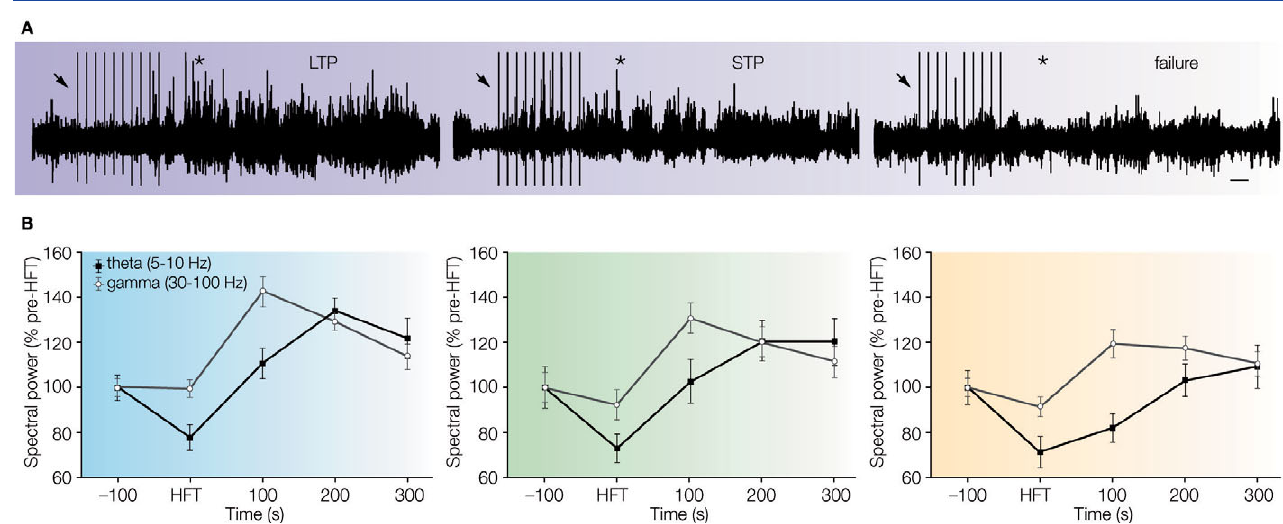
Figure 1 | Transient enhancement of theta and gamma power in the post-tetanisation period correlates with potentiation of synaptic transmission in the dentate gyrus of freely moving rats. (A) Examples of EEG epochs, which comprise 100 s long periods of tetanisation (200 Hz, 10 trains: fi rst train is marked by arrow) and following 300 s, recorded in rats that showed either LTP (left panel), STP (middle panel) or failure of potentiation (right panel), respectively. Asterisk denotes the period immediately after HFT, when the amplitude of network oscillations is higher in LTP and STP cases, in comparison with failed potentiation. Scale bar: 20 s. (B) Successful potentiation (LTP and STP) of synaptic transmission is associated with a prominent increase of the relative theta and gamma power par- ticularly in the period encompassing 100 s after tetanisation. The results were pooled for LTP, STP and failure groups and presented as Mean ± S.E.M. (modifi ed from Bikbaev and Manahan-Vaughan,